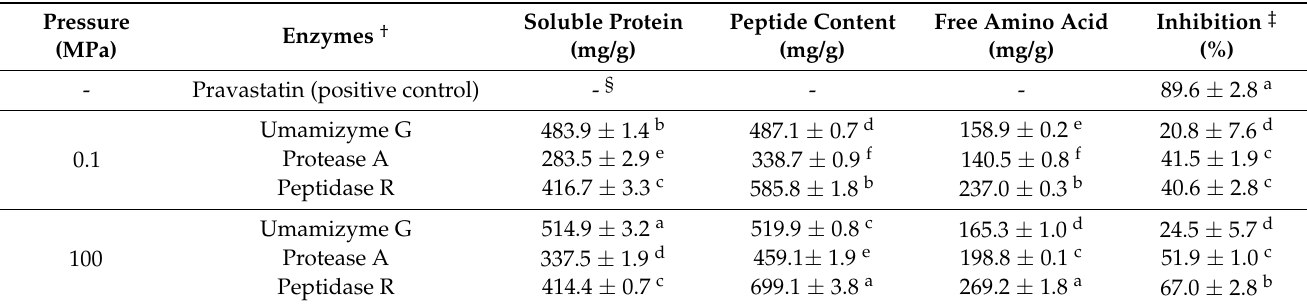
Table 1. Effect of proteases and HHP conditions on soluble protein, peptide, and free amino acid content and HMG-CoA reductase inhibitory activities of spirulina hydrolysates